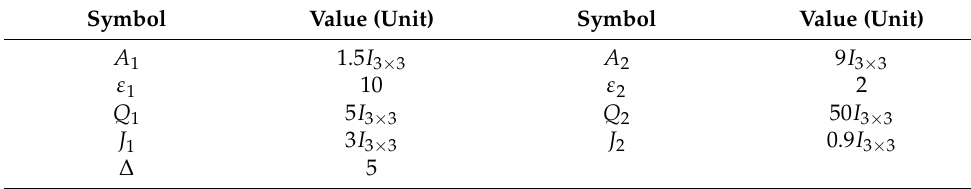
Table 2. Controller